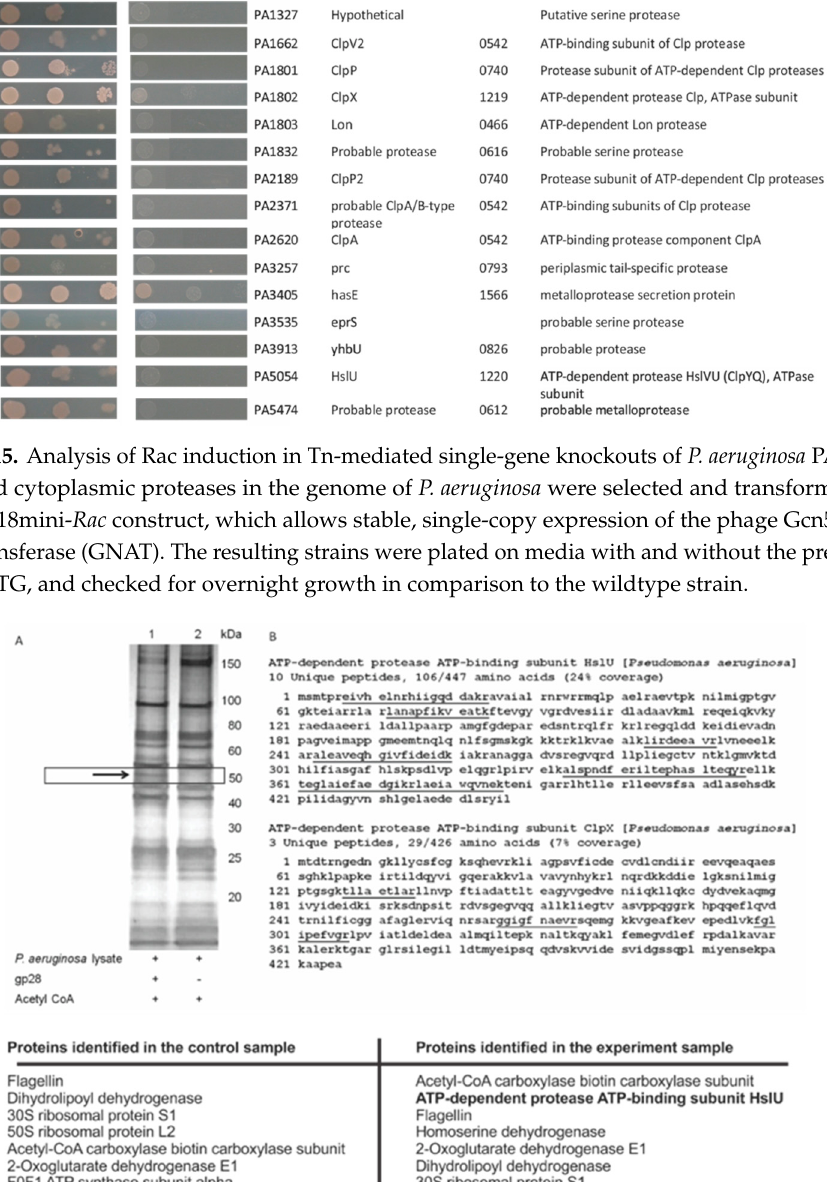
Figure A6. Rac substrate profiling. ( A ) Immunoaffinity enrichment of the Rac substrates from P. aeruginosa cell lysate. The arrow indicates the additional acetylated protein in the presence of recombinant Rac and acetyl-CoA (lane 1), compared to the control sample (lane 2). ( B ) MS analysis reveals that HslU and ClpX are present in lane 1 but not in lane 2, with sequence coverage of 24% and 7%, respectively. The identified peptide sequences are underlined.